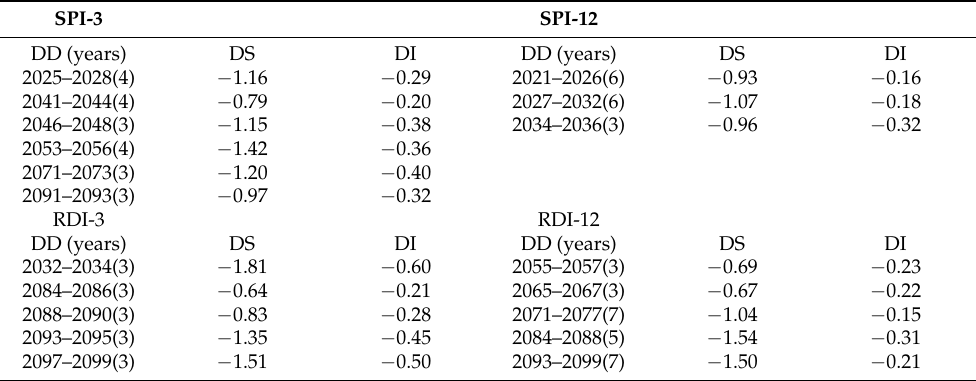
Figure 5. SPI and RDI drought trends at 3 months and 12 months under RCP 8.5. ( a ) SPI drought trends at 3 and 12 month; ( c ) RDI drought trends at 3 and 12 month; ( b ) SPI and RDI drought trends at 12 month; ( d ) SPI and RDI drought trends at 3 month. Table 6. Drought duration (DD), drought severity (DS), and drought intensity (DI) under RCP